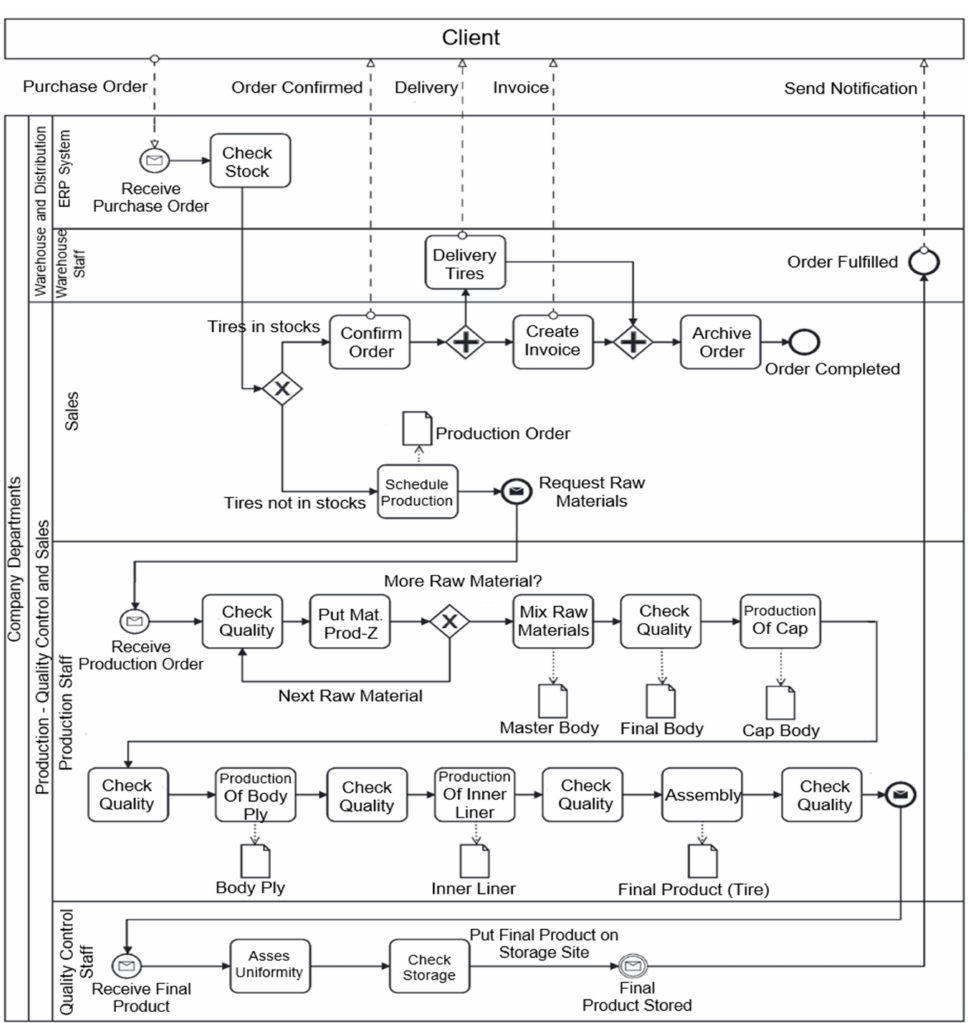
Figure 1. Cloud-based ERP production business process for